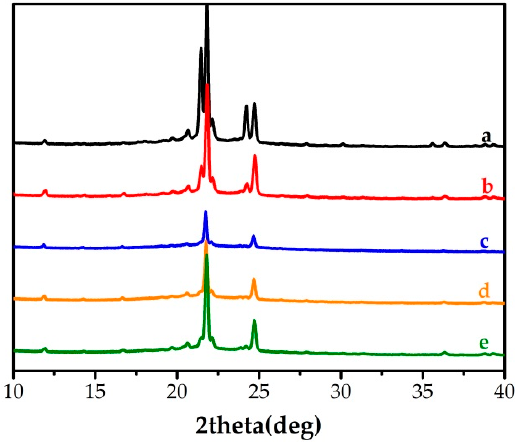
Figure 4. X-ray Di ff raction (XRD) patterns of (a) 1-HD, (b) TC-PCM 180 , (c) TC-PCM 130 , (d) TC-PCM 90 , Figure 4. X-Ray Diffraction ( XRD) patterns of (a) 1-HD, (b) TC-PCM 180 , (c) TC-PCM 130 , (d) TC-PCM 90 , (e) TC-PCM 50 (e) TC-PCM 50.